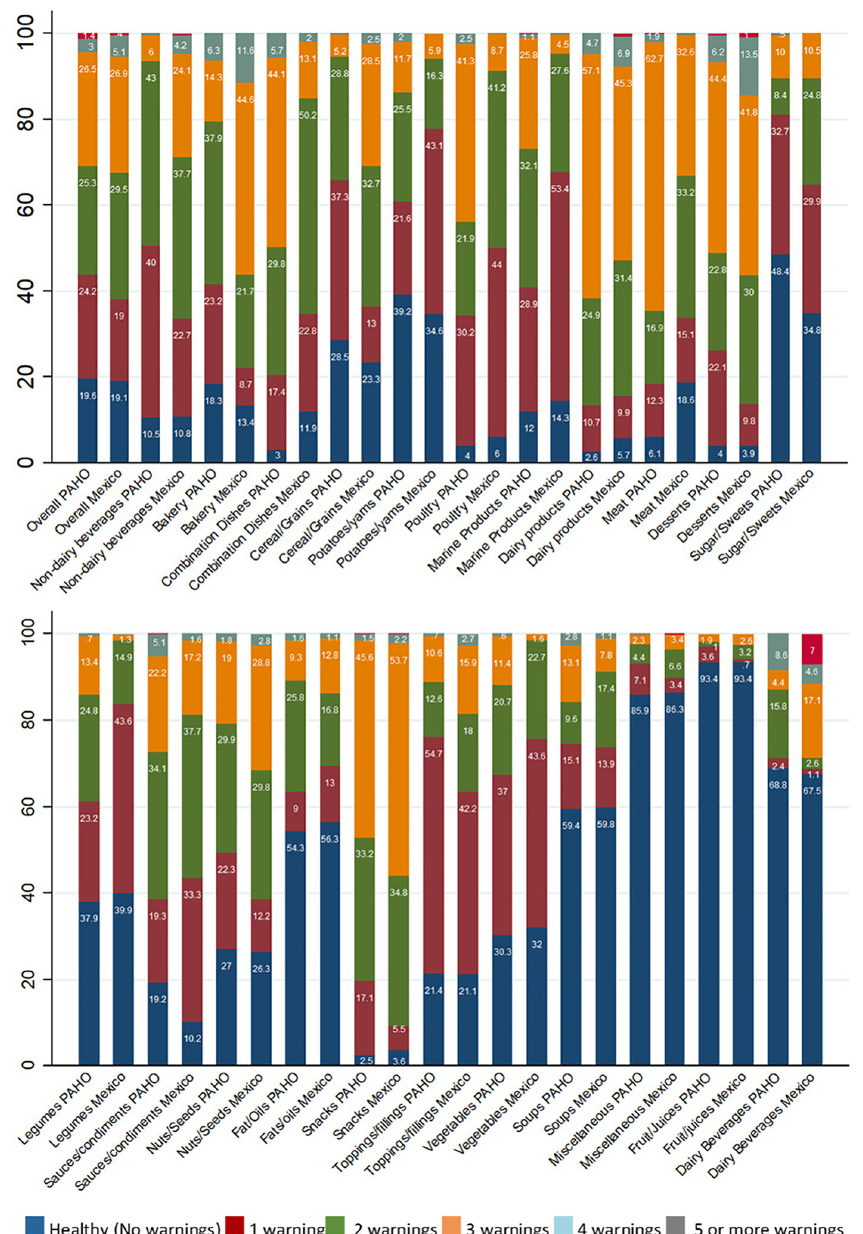
Fig 2. Percentage of products with 0 to 5 or more warning labels assigned by the PAHO model and the Mexico Phase 3 nutrient profile, overall and by food group ( n = 36,844 unique packaged products). All comparisons were statistically significant ( p < 0.05). PAHO, Pan American Health